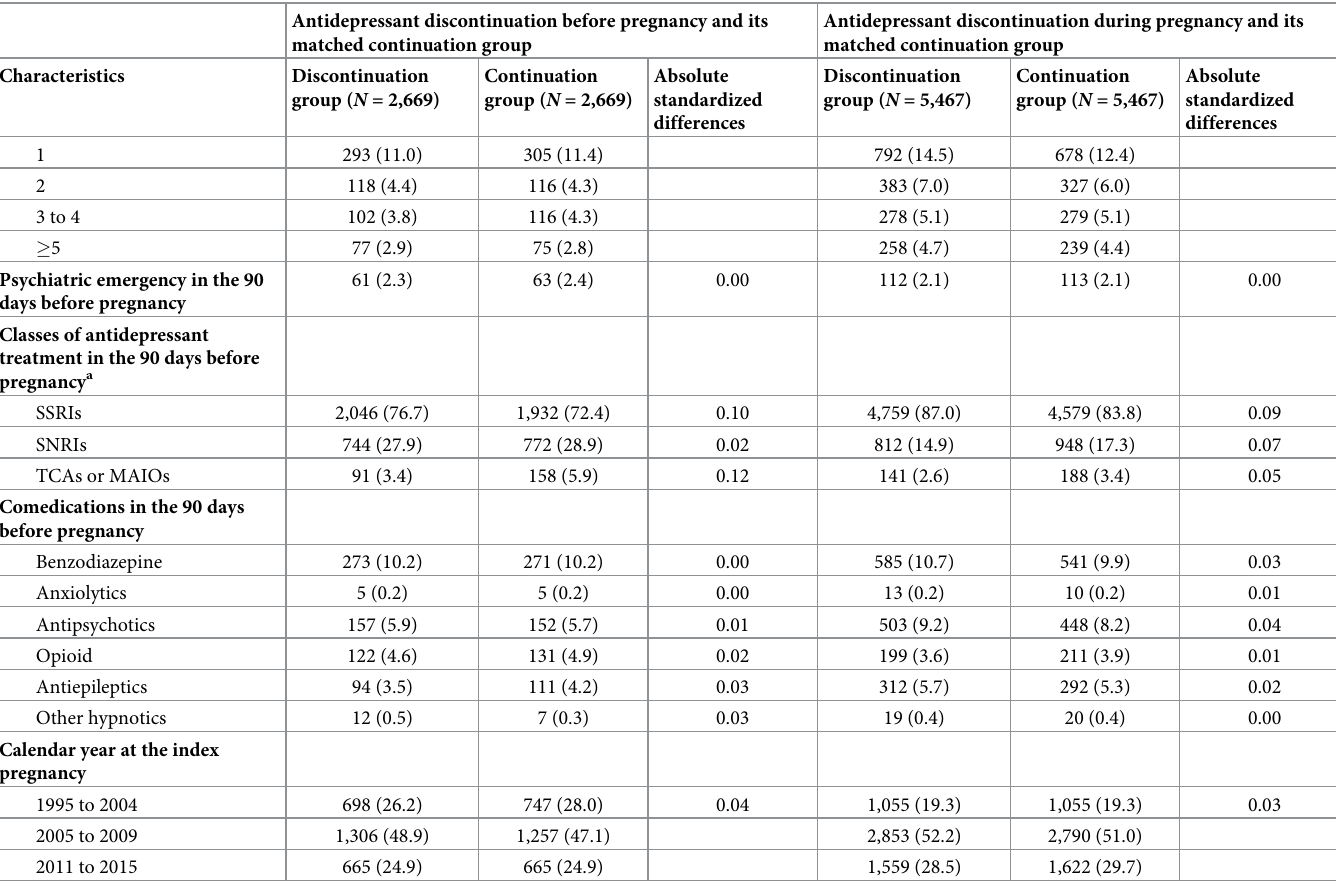
shows the Kaplan–Meier curves for psychiatric emergency in the perinatal period by antidepres- sant discontinuation before pregnancy versus continuation during pregnancy. Antidepressant discontinuation before pregnancy was not significantly associated with increased psychiatric emergency risk (HR = 0.84, 95% CI: 0.61 to 1.16, p = 0.298). The risk of psychiatric emergency associated with antidepressant discontinuation before pregnancy did not differ between the preg- nancy and the postpartum periods ( p -value for interaction = 0.410).